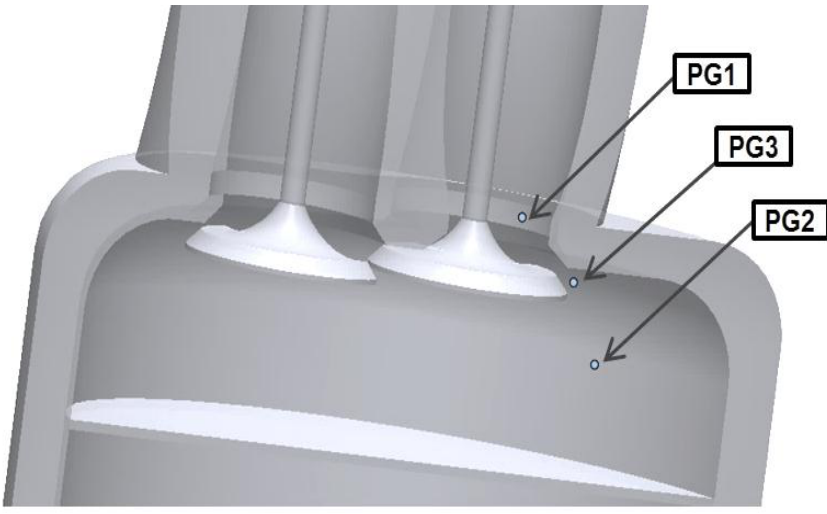
Figure 7. Computational location (Point Goals).